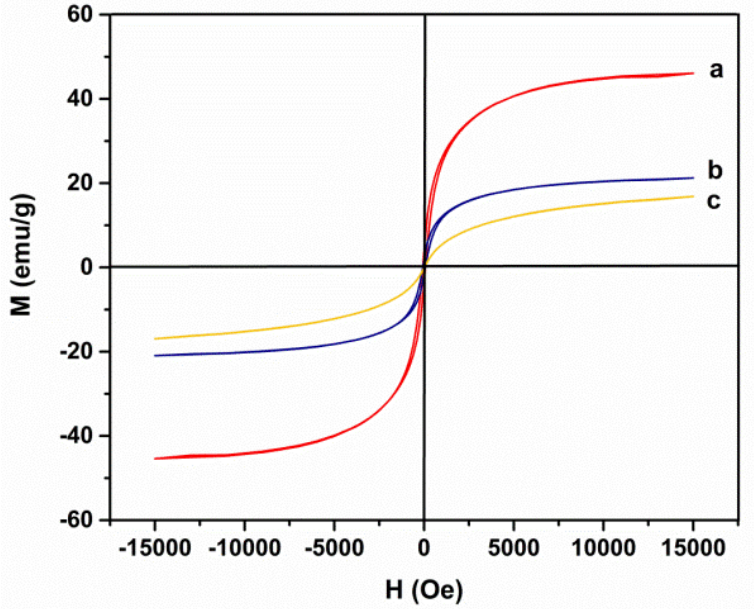
Figure 3. Magnetization curves for the as-synthesized ( a ) Ni 1−x Co x Fe 2 O 4 NPs, ( b ) Ni 1−x Co x Fe 2 O 4 @Methionine NPs, and ( c ) Ni 1−x Co x Fe 2 O 4 @Methionine@PEG NPs.